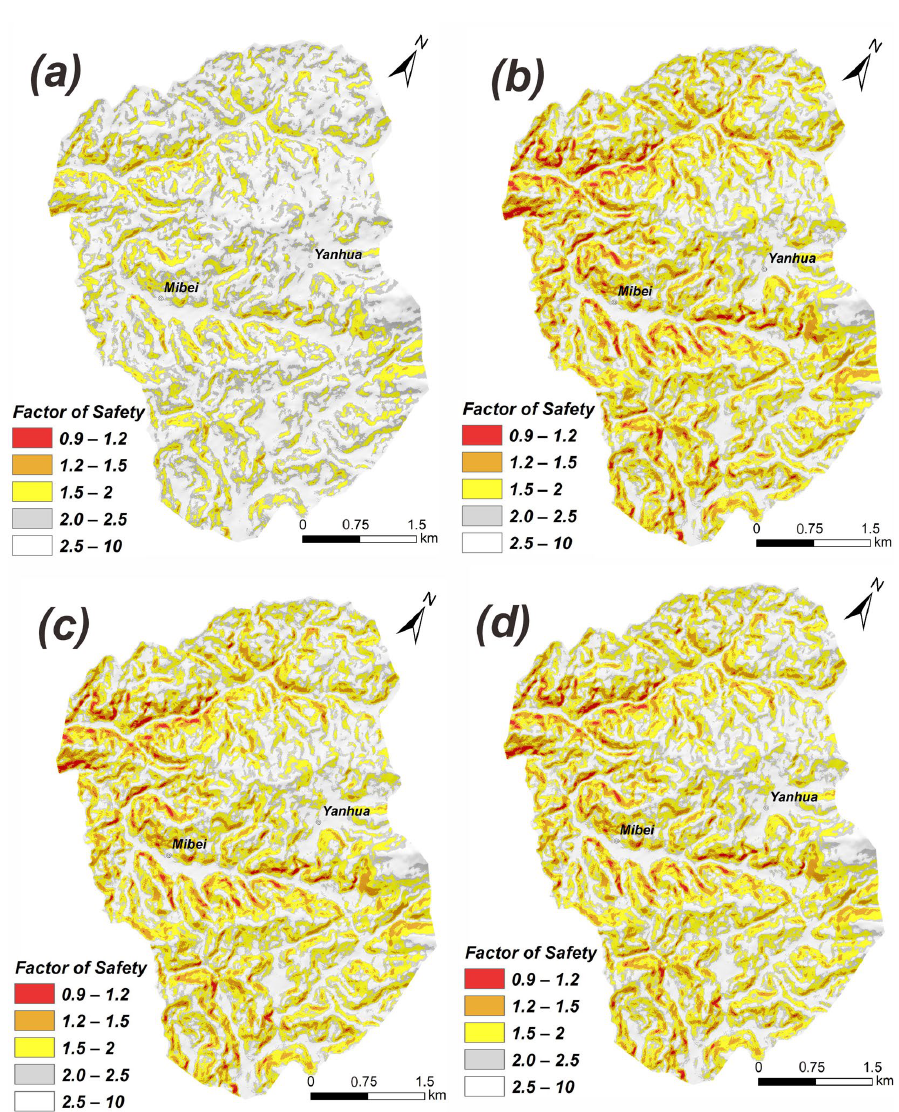
Figure 18. Slope stability conditions, expressed in terms of Safety of Factor (FS) in different time periods of this rainfall event; ( a ) 20:00 on 9 June 2019 (UTC + 8, before rainfall event); ( b ) 8:00 on 10 June 2019 (UTC + 8); ( c ) 20:00 on 11 June 2019(UTC + 8); ( d ) 8:00 on 13 June 2019(UTC + 8). We calculated the Fs results in the various slope interval over different time periods (Figure 19). The result shows that the Fs of the grids with slope angles between 30 and 40° was mostly distributed between 1.3 and 2.5, with an average value of around 1.6. After the onset of heavy rain on 10 June 2019, the Fs of raster cells rapidly decreased, and the Fs of most grids ranged between 0.9 and 1.7, with an average value of about 1.2. From 8:00 on 10 June 2019, although there was rainfall every day at a subsequent stage, the average rainfall was less than 2 mm/h. The low rainfall intensity had a little impact on the slope stability. Rainfall increased to some extent on 12 June 2019, reaching 45 mm in 12 h, and the Fs decreased slightly. For grids with a slope larger than 40°, we also found the same